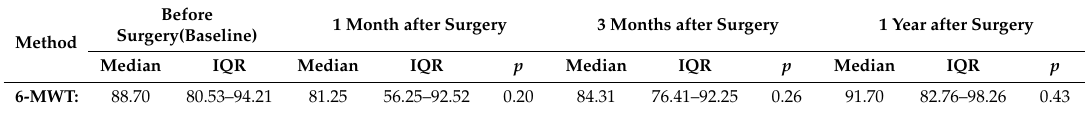
Table 5. Exercise capacity measured by the 6-min walking test (6-MWT).